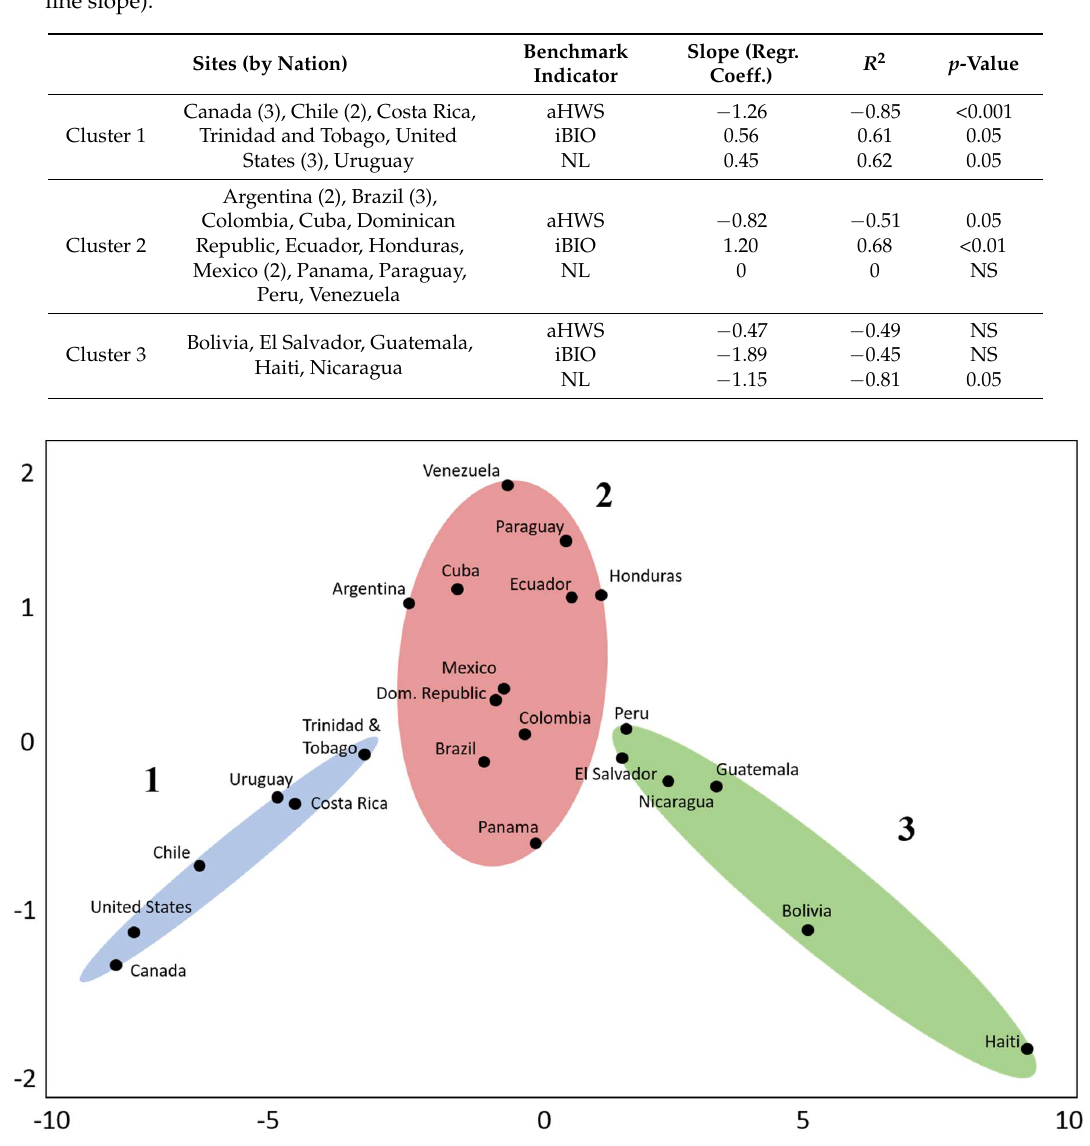
Figure A1. Results from cluster analysis of study nations based on historical values (1996–2015) of GDPP, ACSAT, and RL (R Package https://uc-r.github.io/kmeans_clustering).